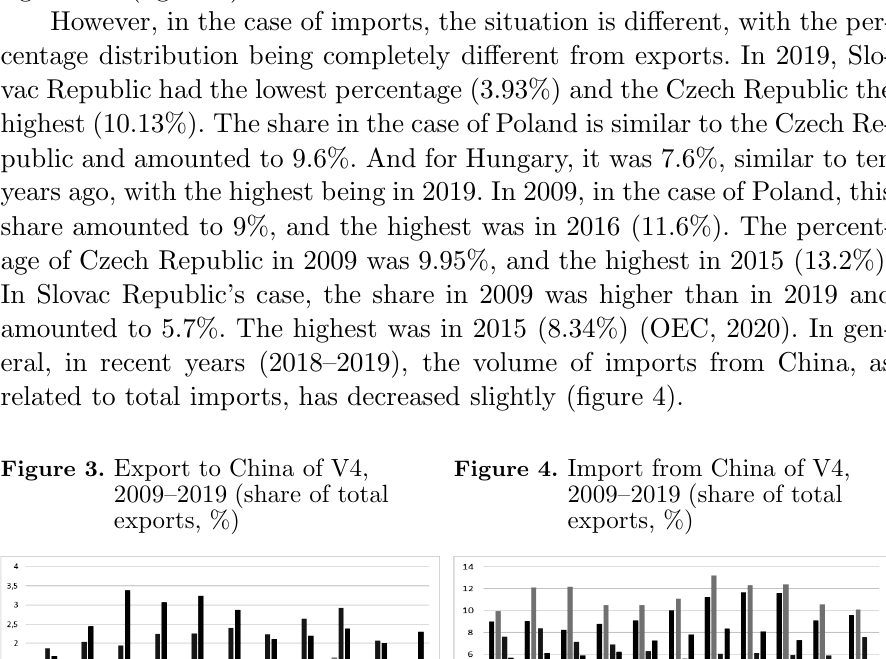
2009–2019 (share of total exports, %)